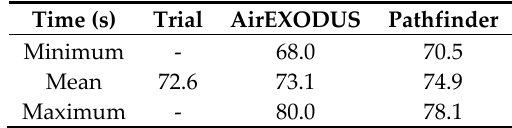
Table 2. Evacuation time comparison of trial, airEXODUS and Pathfinder in case study 2.